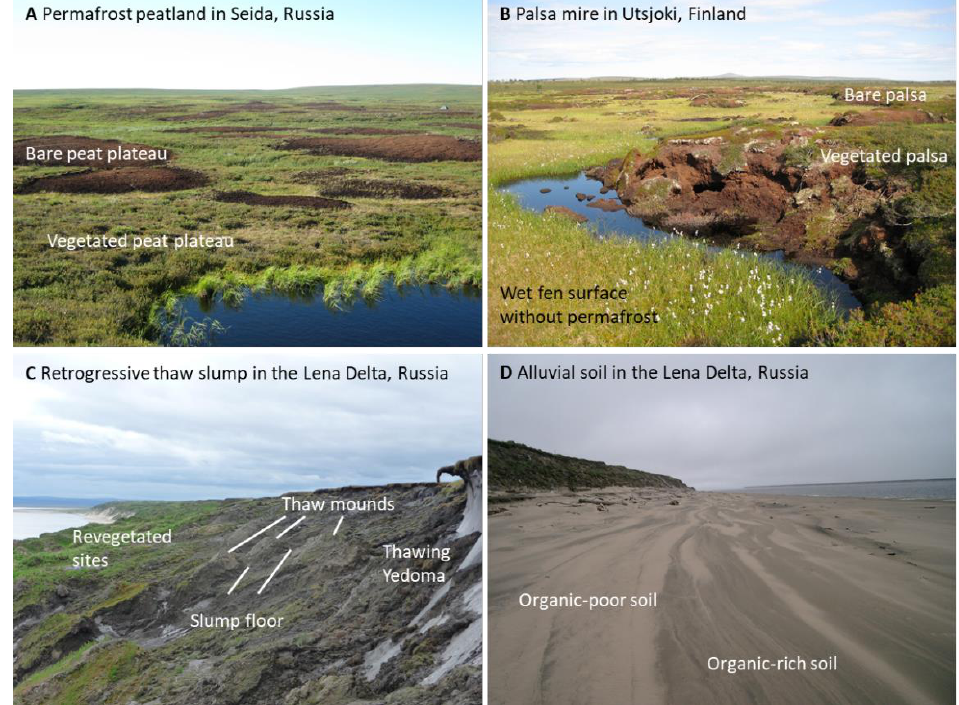
Figure 3. Photographs of hotspots with high N availability. ( A ) permafrost peatland in Seida, Komi Republic, Russia (N 67°03 ′ , E 62°57 ′ ) with bare peat and vegetation on the frozen peat plateau (July 2010, Maija Marushchak), ( B ) palsa mire in Utsjoki, Finland (N 67°45 ′ , E 27°00 ′ ) with bare and vegetated palsa underlied by permafrost and wet fen surface without permafrost (August 2009, Maija Marushchak), ( C ) retrogressive thaw slump on Kurungnakh Island, Lena River Delta, Russia (N 72°20, E 126°17 ′ ), with bare and revegetated slump floor and thaw mounds (July 2016, Alexander Schütt), ( D ) alluvial soils on Samoylov Island, Lena River Delta, Russia, (N 72°22, E 126°28 ′ ) with bare bright organic-poor and dark organic-rich soil surfaces (July 2008, Claudia Fiencke).